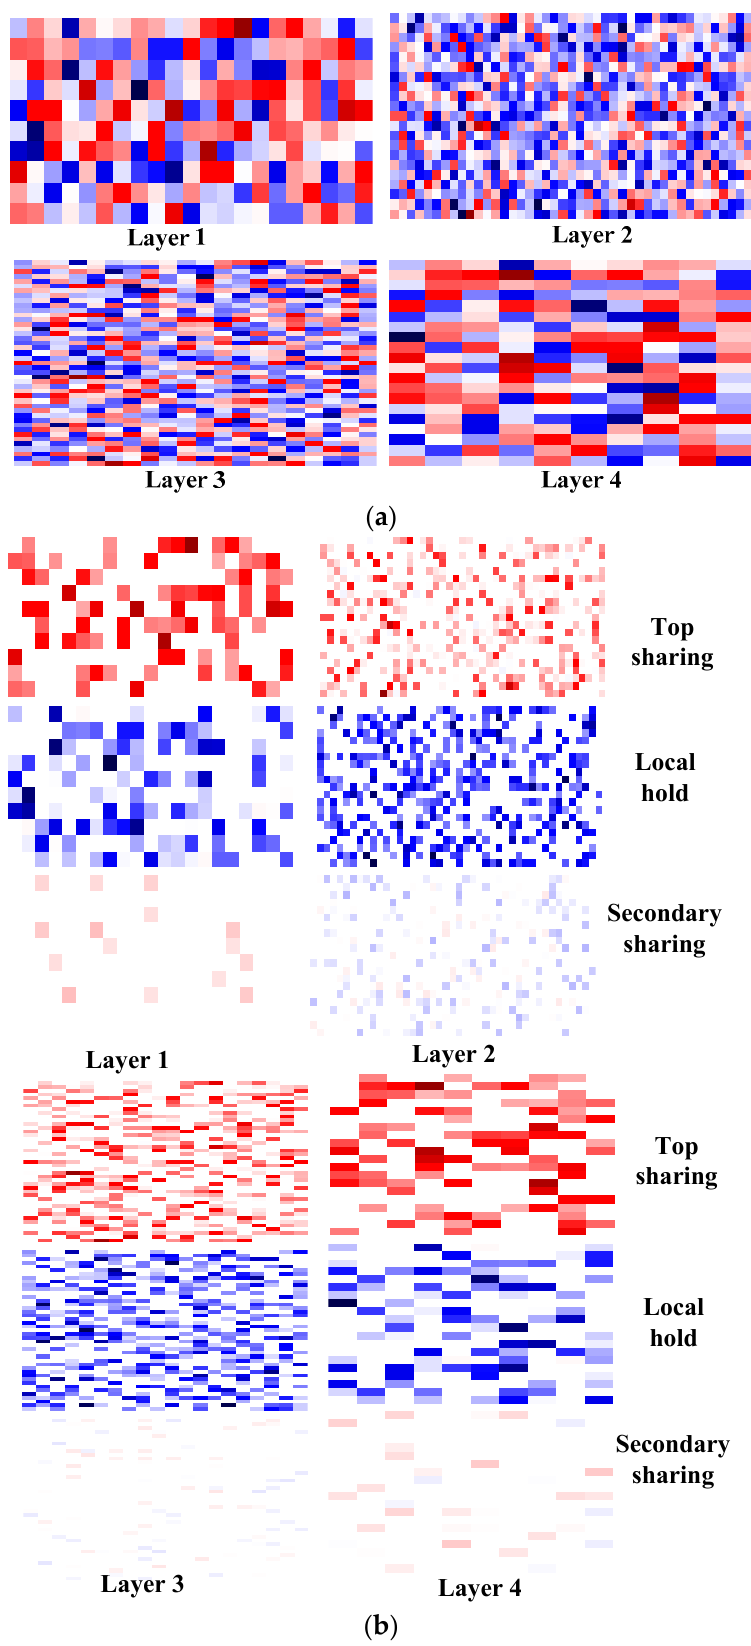
Figure 9. Rw map. ( a ) Schematic diagram of a four-layer network Rw map. ( b ) Layered diagram of the multi-level of a four-layer network.